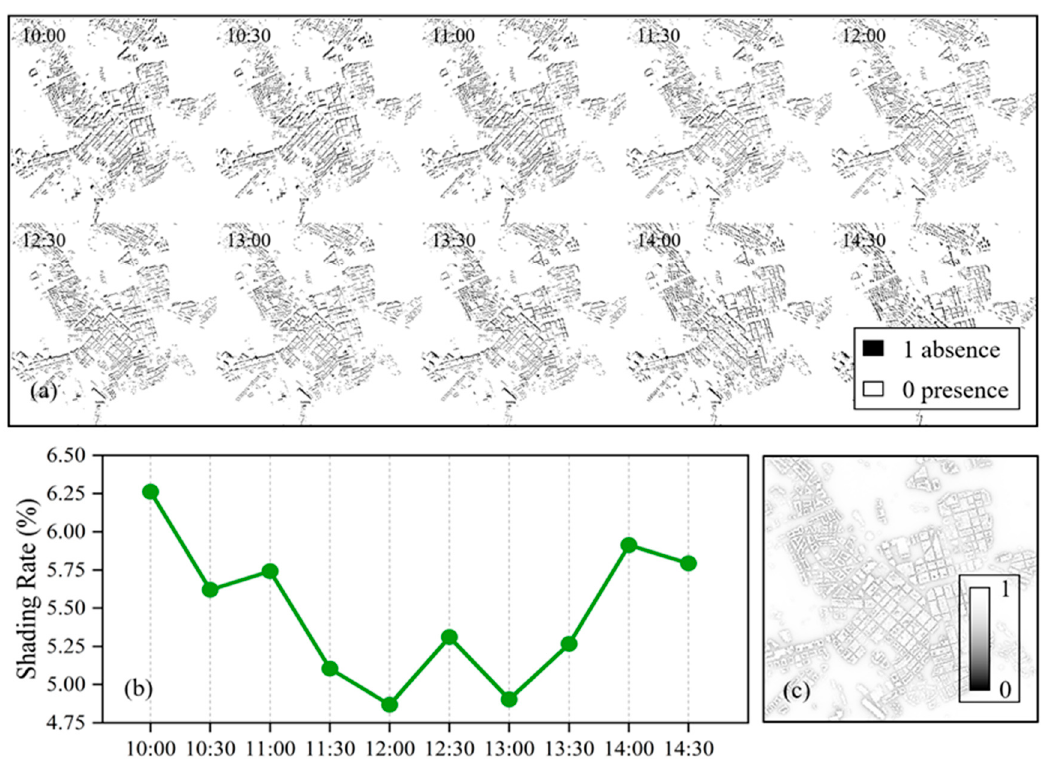
Figure 5. Plots showing ( a ) the Boolean shadow of the study areas at different times; ( b ) the variation of the shading rate in the study area; ( c ) the sky view factor of the study area from 10:00 to 15:00 on 24 July 2018.